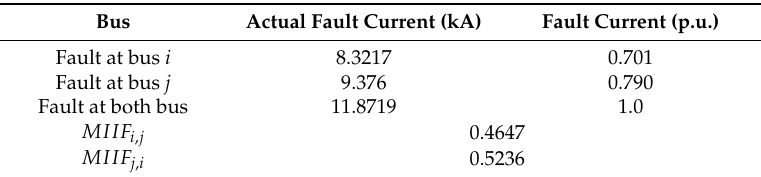
Table 1. MIIF calculation by fault current